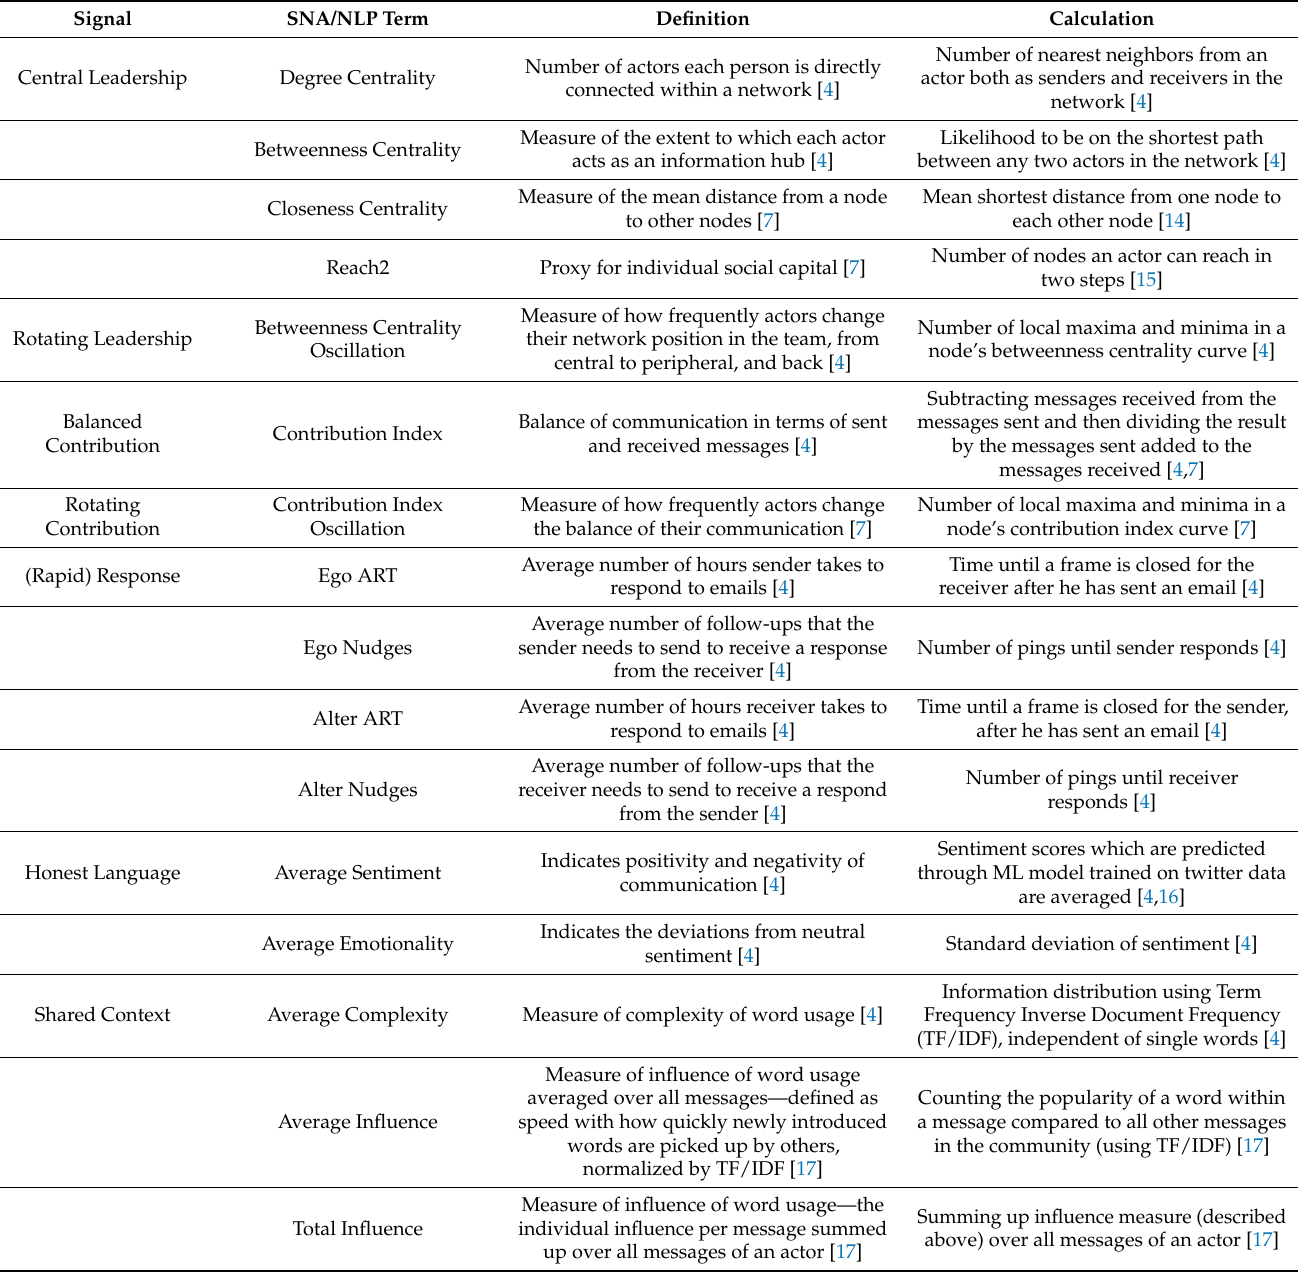
Table 1. Definition of Honest